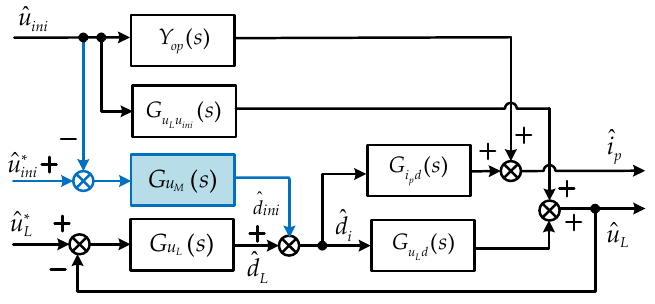
Figure 4. Control block diagram of the i -th ( i = 1, 2 … n − 1) DAB module.